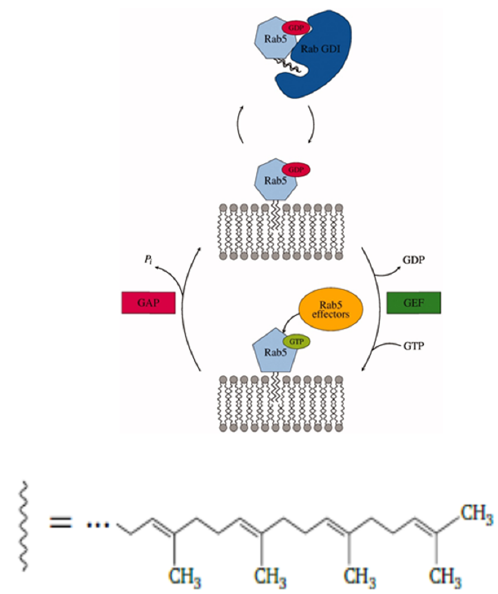
Figure 1. Rab proteins shuttle between inactive, GDP-bound, and active, guanosine triphosphate (GTP)-bound states, which affect their cellular localization. The protein is post-translationally modified and lipidated by a transferase with two 20-carbon lipophilic geranylgeranyl isoprene units. Transport between different vesicular membranes is realized by RabGDI, which exclusively binds Rab(GDP). Guanine nucleotide exchange factors (GEFs) catalyze the exchange of GDP to GTP and thereby the activation of Rab proteins. Rab(GTP) is solely membrane-associated and able to recruit a large number of effector proteins. GTP hydrolysis and recovery of Rab(GDP) is achieved by GTPase activating proteins (GAPs) [5].